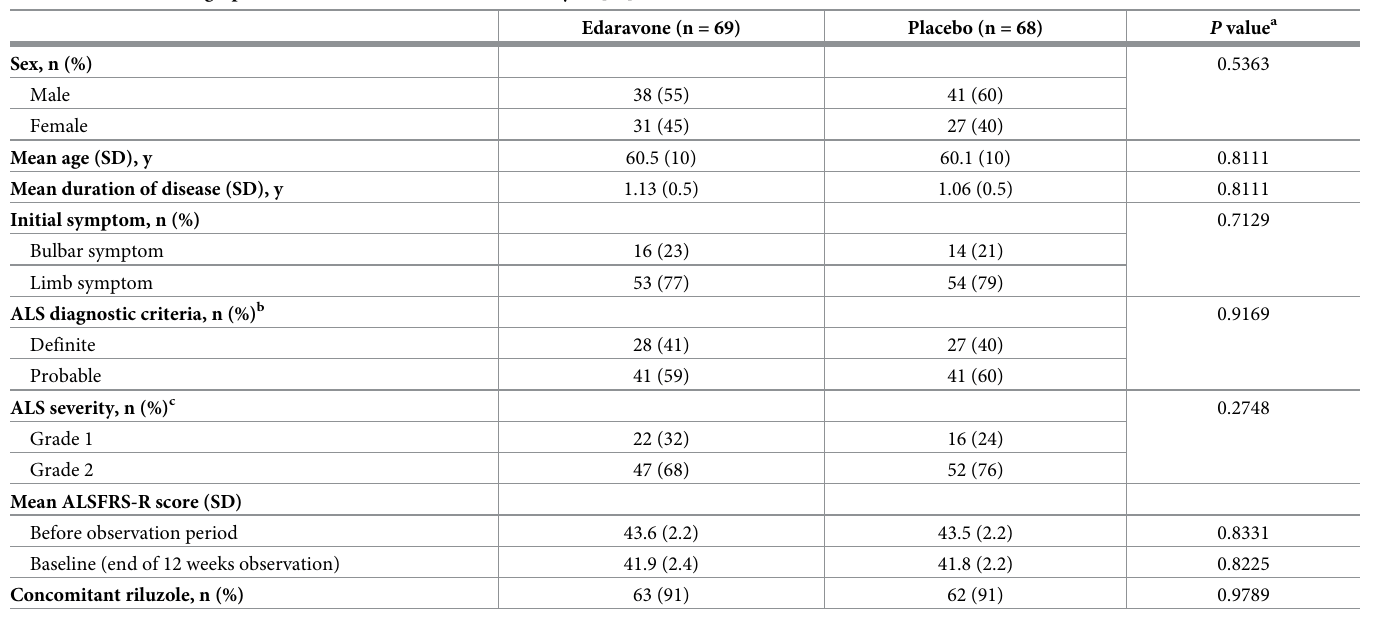
Table 1. Baseline demographics and clinical characteristics in Study 19 [11].